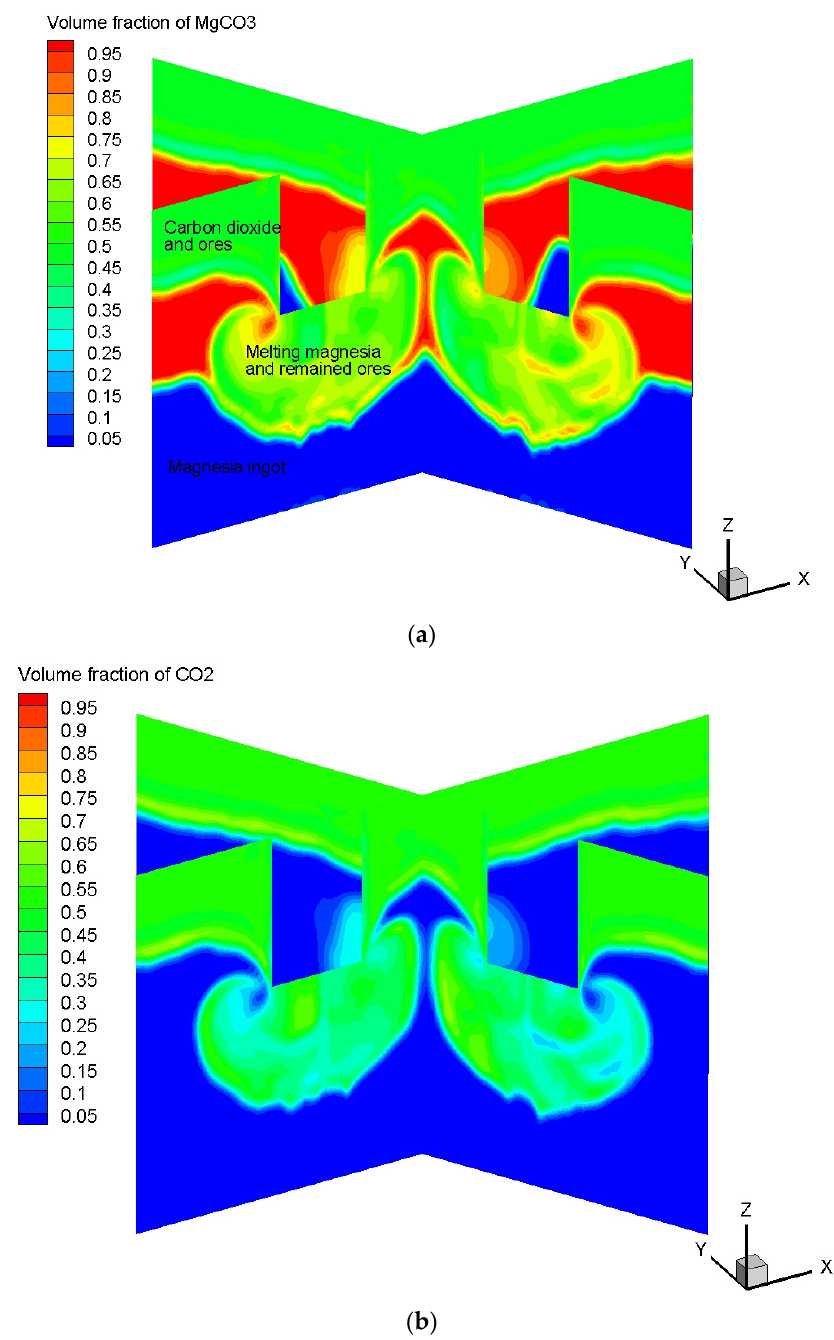
Figure 10. ( a ) Decomposition state of magnesium carbonate. ( b ) Carbon dioxide formation state.